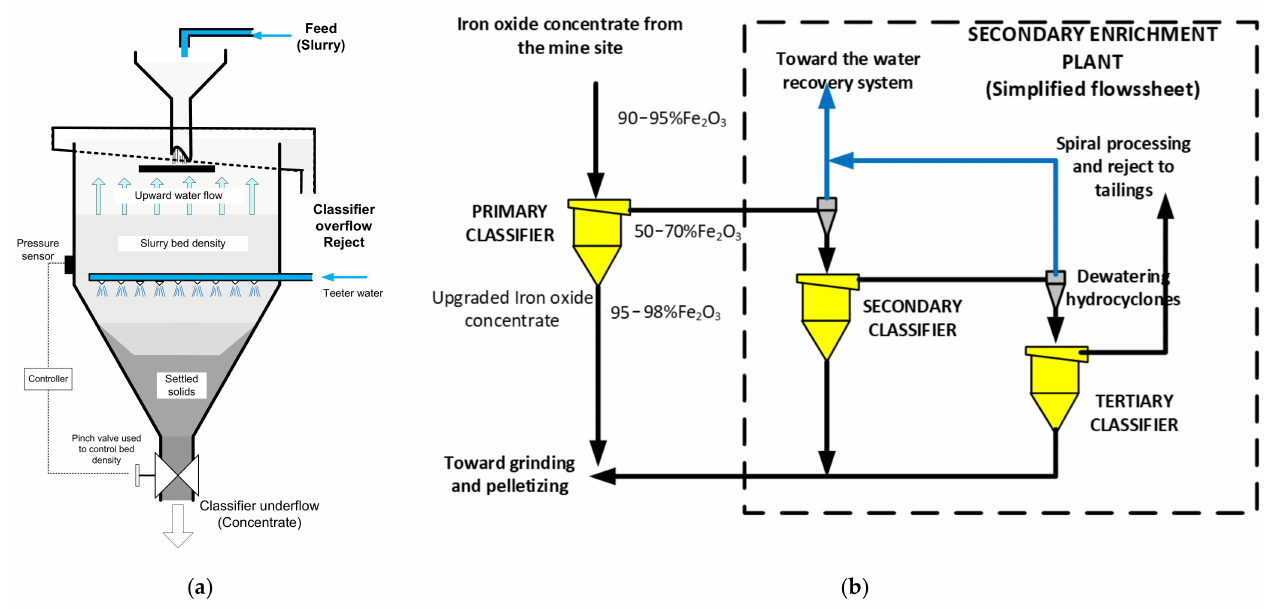
Figure A2. Simplified diagrams of the ( a ) hydraulic classifier and ( b ) primary upgrading of the